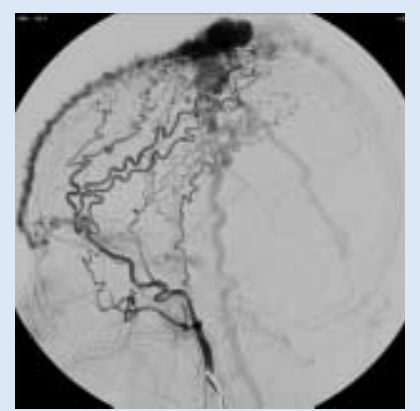
Fig. 2. High-flow (arteriovenous) malformation of the scalp. This composite digital subtraction angiogram combines both the arterial and venous phases in one